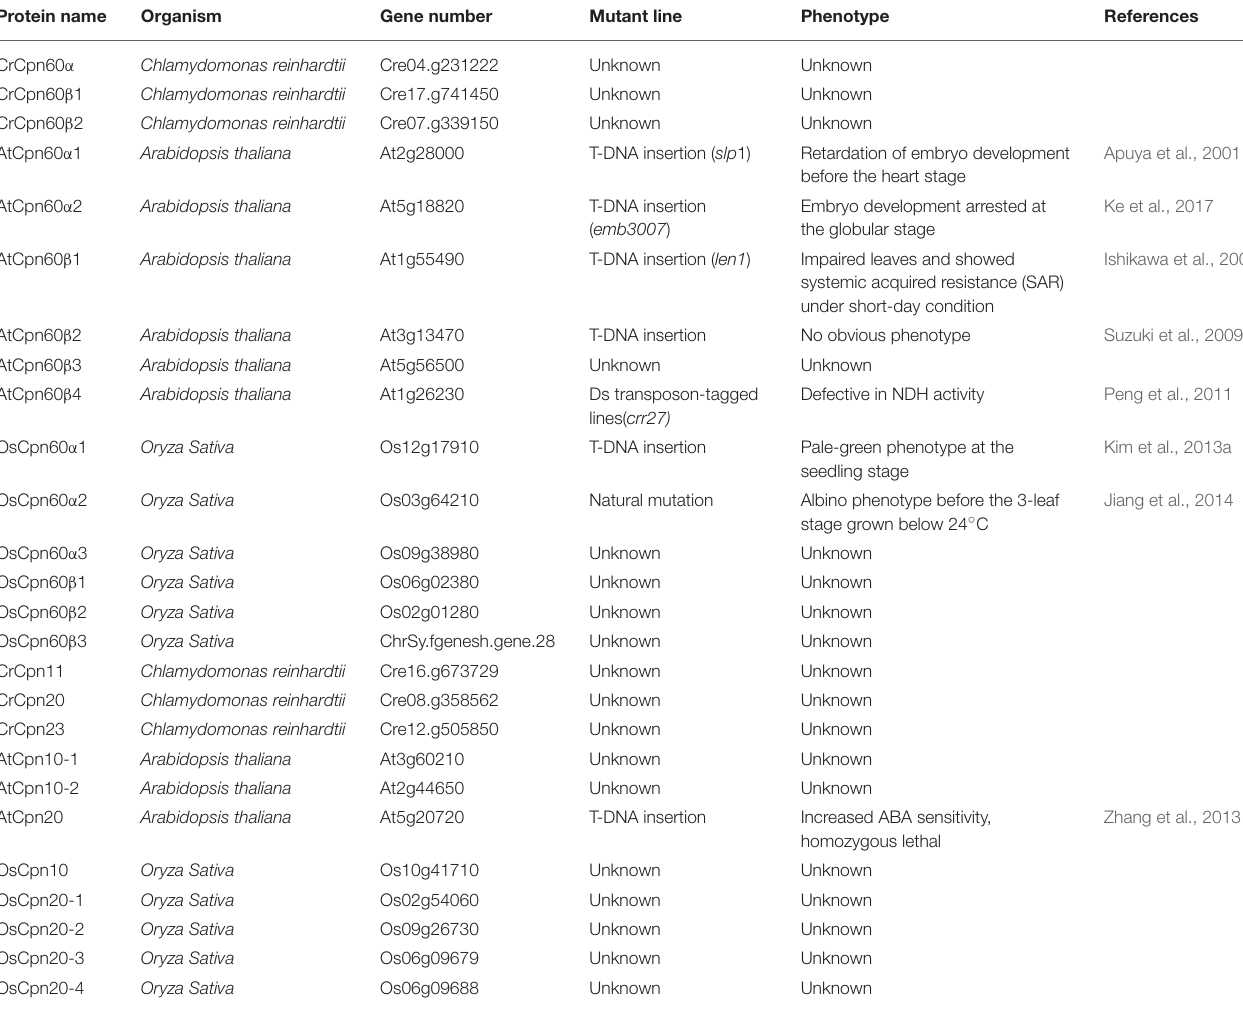
TABLE 1 | Chloroplast chaperonins and co-chaperonins in model species: nomenclature and